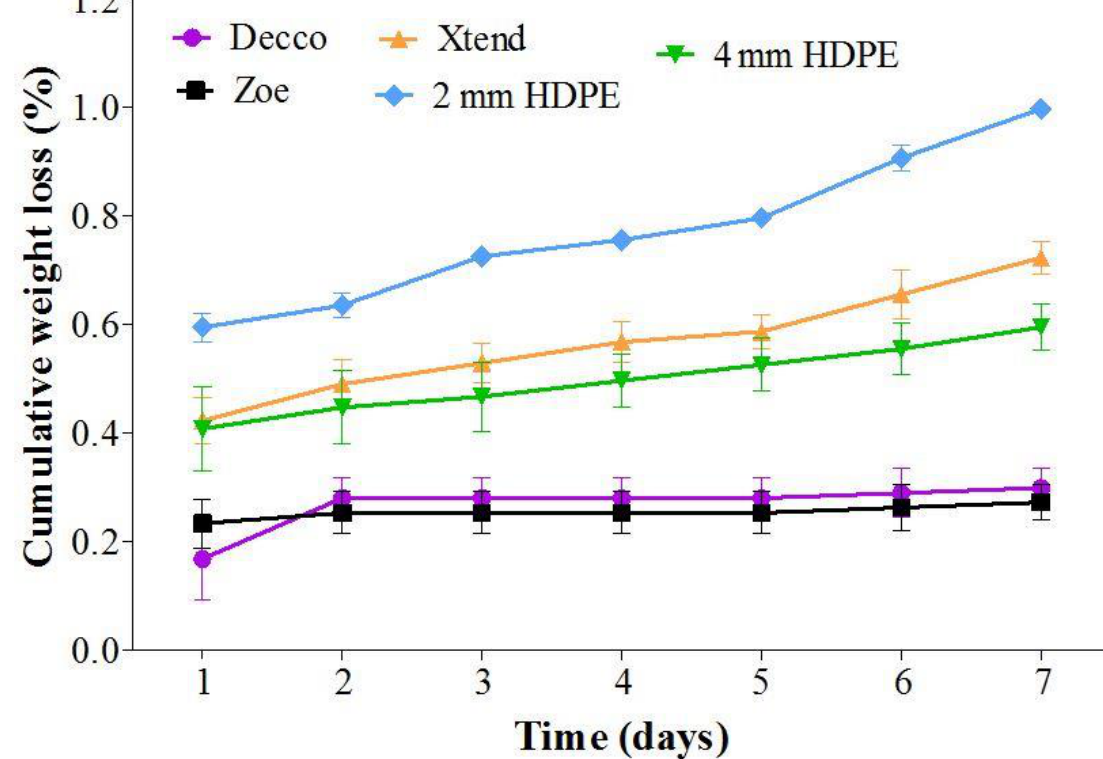
Figure 7. Cumulative percentage loss in weight during condensation variation within liner bags. Pomegranate (cv. Wonderful) stored at 5 °C and 90% relative humidity (RH). HDPE: high density polyethylene.